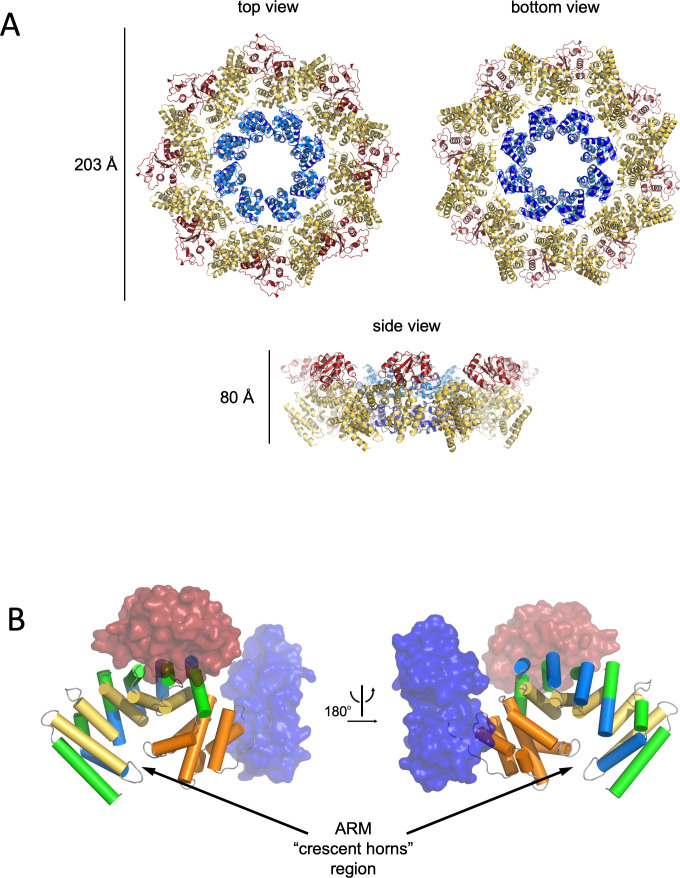
Structure and domain organisation of hSARM1.(A) Cartoon model of hSARM1. Color code is as in Figure 1A. (B) Architecture of the crescent-shaped ARM domain. The structure reveals that there are two ARM subdomains, one spanning res. 60–303 with five 3-helix (depicted as green, yellow, and blue cylinders) ARM repeats, and the second (res. 322–400) with two repeats, all colored in orange. The SAM and TIR domains are represented as transparent blue and red surface, respectively.